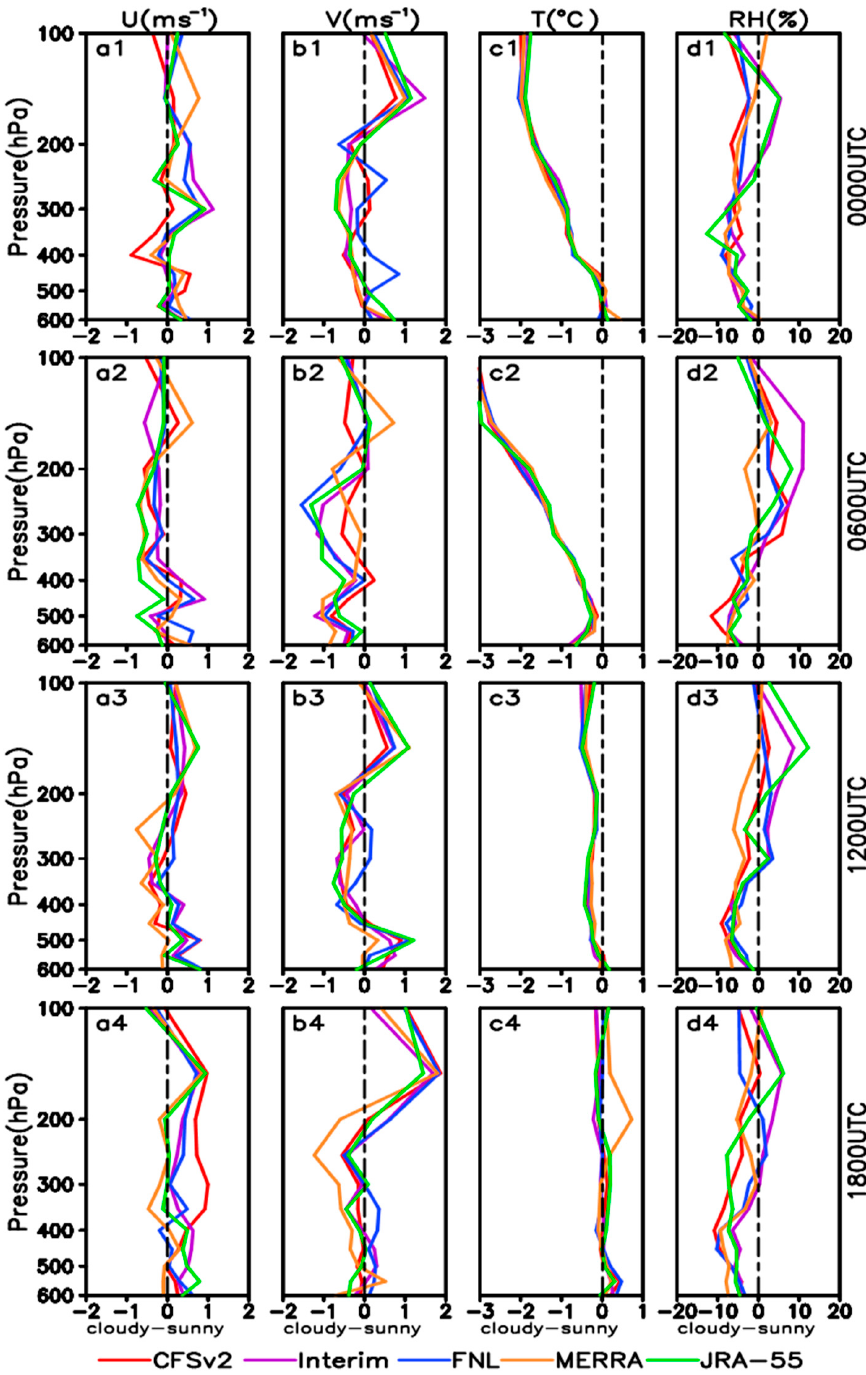
Figure 9. The difference of the RMS errors of U ( a1 – a4 ), V ( b1 – b4 ), T ( c1 – c4 ), and RH ( d1 – d4 ) between those on cloudy days and on sunny days in the GDs against the radiosonde data, averaged over sounding six sites in the TP.